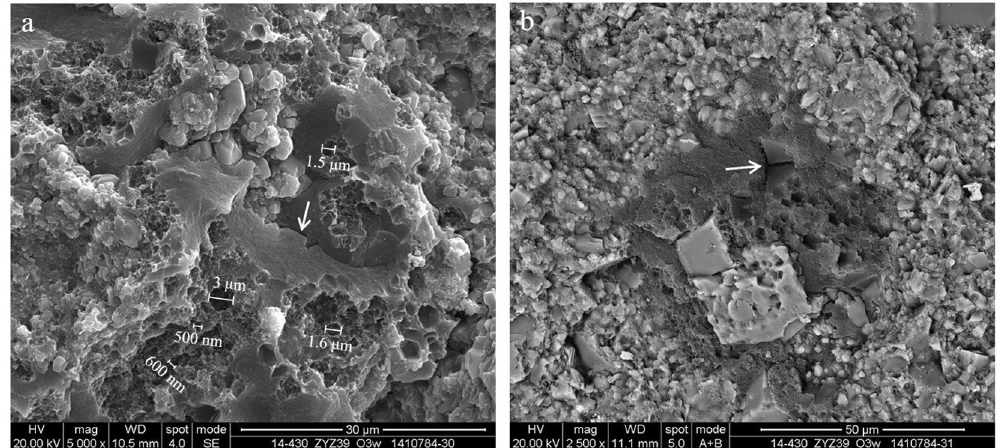
Figure 7. Pores in the solid bitumen of the Wufeng Formation in well Jiaoye 2 (2570.89 m). ( a ) The honeycomb- like bitumen-hosted pores. The diameters are typically 500–600 nm, while pores as large as several μ m in diameter are also observed. Cracks are observed in the bitumen (white arrow). ( b ) The honeycomb-like bitumen-hosted pores. Cracks are observed in the bitumen (white